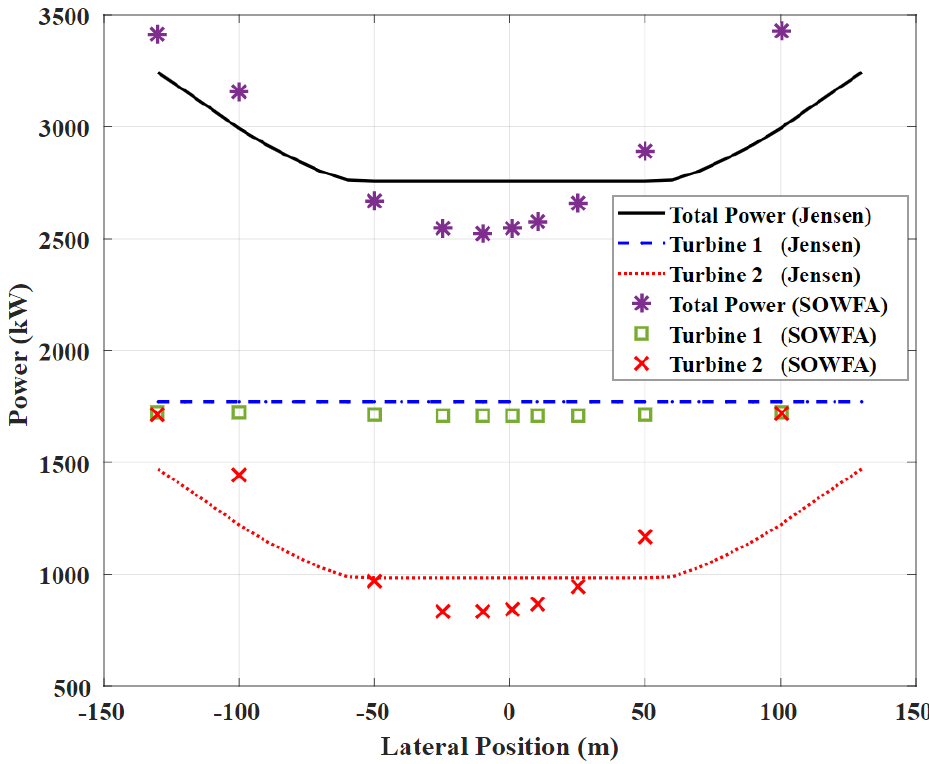
Figure 6. Comparing results obtained from our Jensen implementation and those of CFD